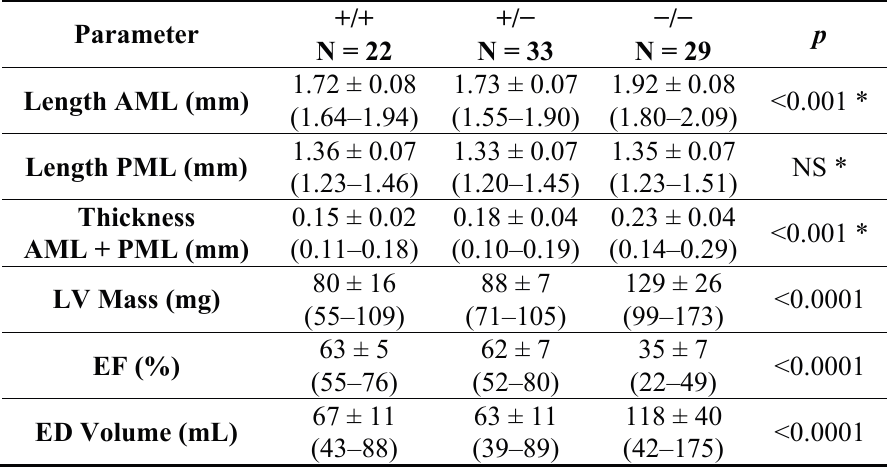
Table 1. Cardiac findings using high resolution echocardiography.